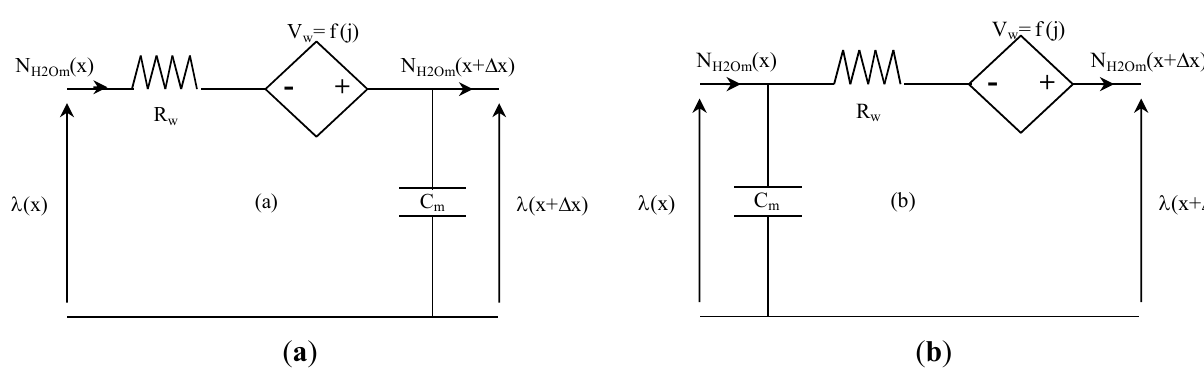
Figure 6. Equivalent electrical circuit for water transport in the